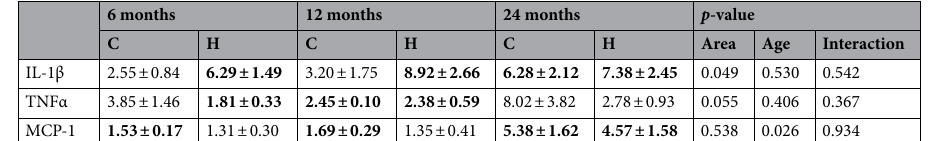
Table 2. Gene expression levels (2 –ΔΔCt ) of pro-inflammatory cytokines, in different brain regions and at different postnatal ages, in AD (APPswe/PS1dE9) Tg mice with respect to age-matched WT mice. Data are reported as mean ± SEM. p-values derived from a linear mixed model with brain region as the within variable and age as the between variable. Statistically significant comparisons with respect to WT mice are shown in bold characters (p < 0.05). C cortex, H